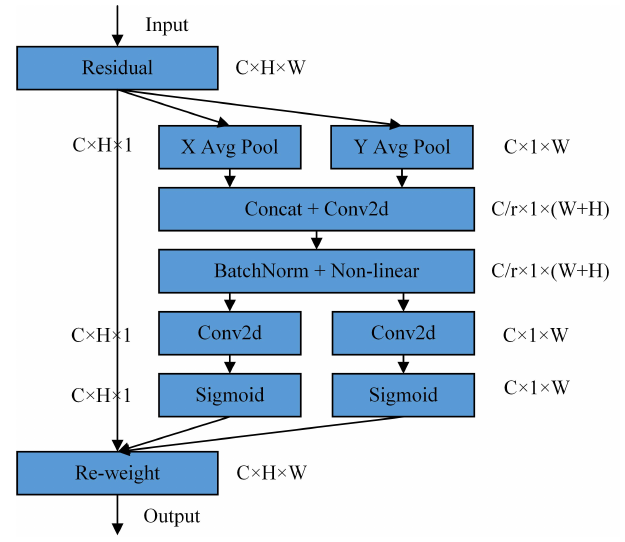
Figure 4. The structure of coordinate attention